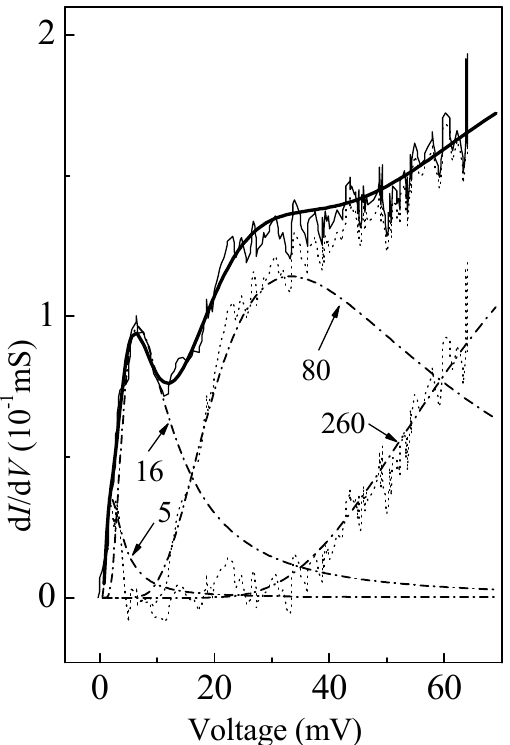
Figure 5. Deconvolution of the local G(V) curve into elementary terms with the characteristic splitting energies of the levels δ E i = 5, 16, 80, and 260 meV. The thin solid line is the experimental curve [32]. The dash-dotted lines are the elementary terms. The thick solid line is the sum of the terms. The dotted lines are residuals after subtraction of the terms.